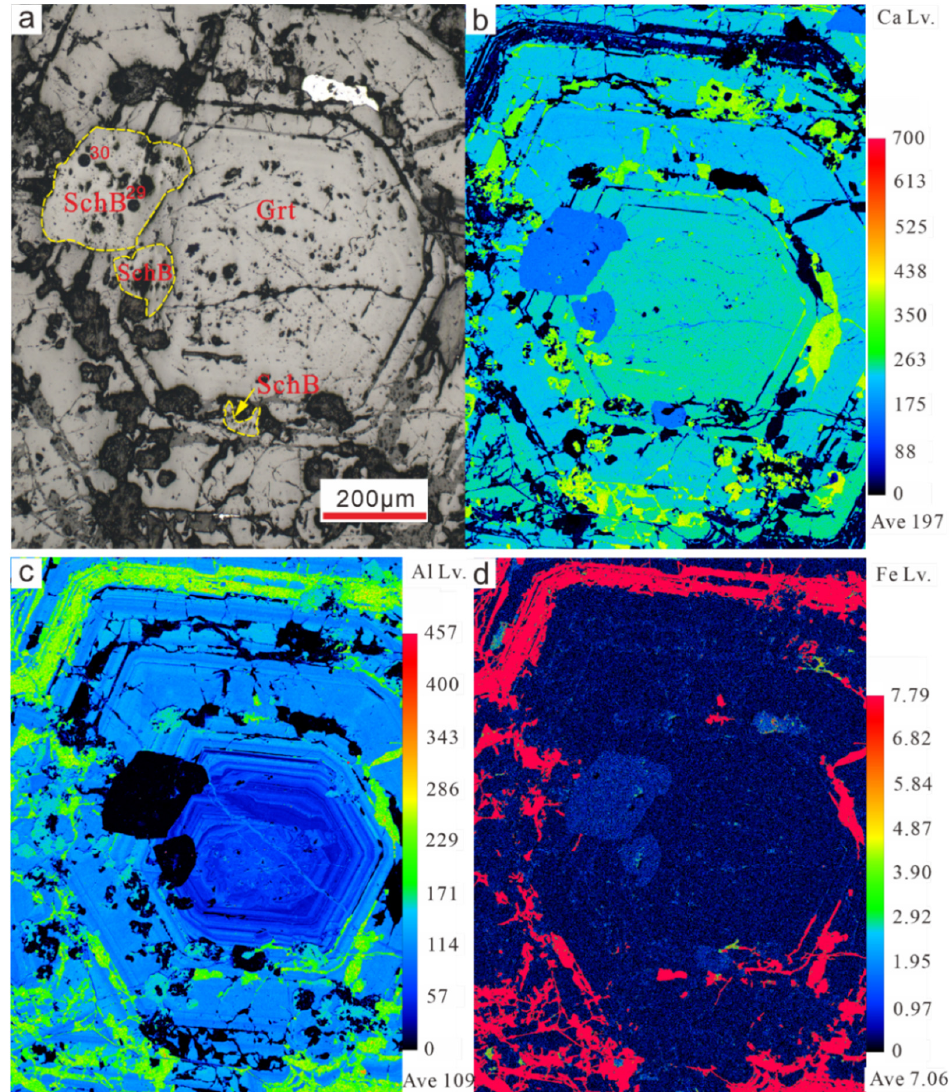
Figure 6. ( a ): Image taken under the microscope of SchB, which coexists with garnet that could have grown in a similar disturbed environment during garnet formation; ( b – d ): SchB has an evolution tendency from inner grossular zones (which has relative lower Fe content) to andradite zones within distal rims (which has obvious higher Fe content). This can result from a highly disturbed growing environment, and andradite crystalized faster than grossular in this environment [20].